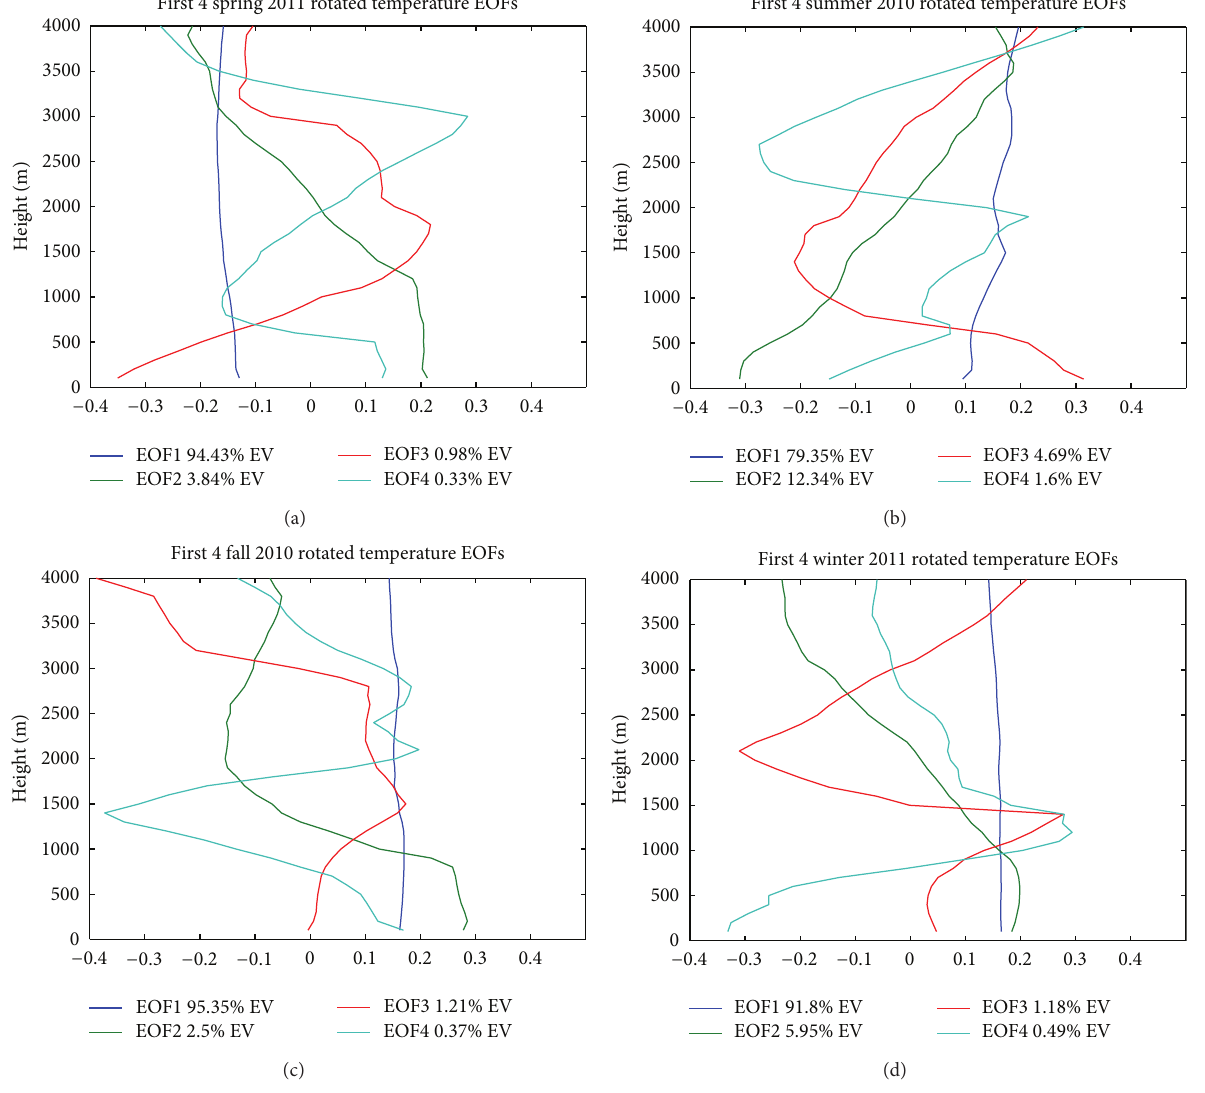
Figure 4: Rotated empirical orthogonal function (EOF) pattern vectors for vertical temperature profiles from 06UTC (15LST) radiosonde observations at Osan in four seasons: spring 2011 (a), summer 2010 (b), fall 2010 (c), and winter 2011